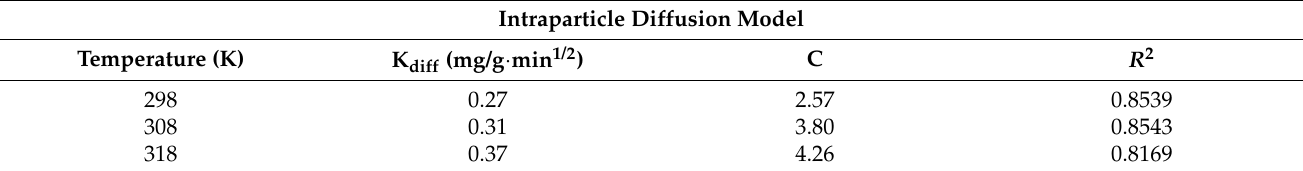
Table 4. Specific parameters of intraparticle diffusion for SiO2FexOy.